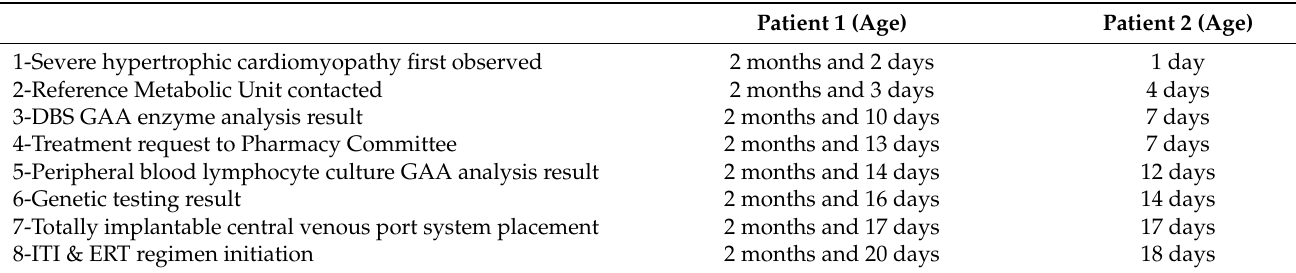
Table 1. Timing at the different stages of the diagnostic and specific treatment initiation procedure. Dried blood spot (DBS); acid alpha-glucosidase (GAA); immune tolerance induction (ITI); enzyme replacement therapy (ERT).